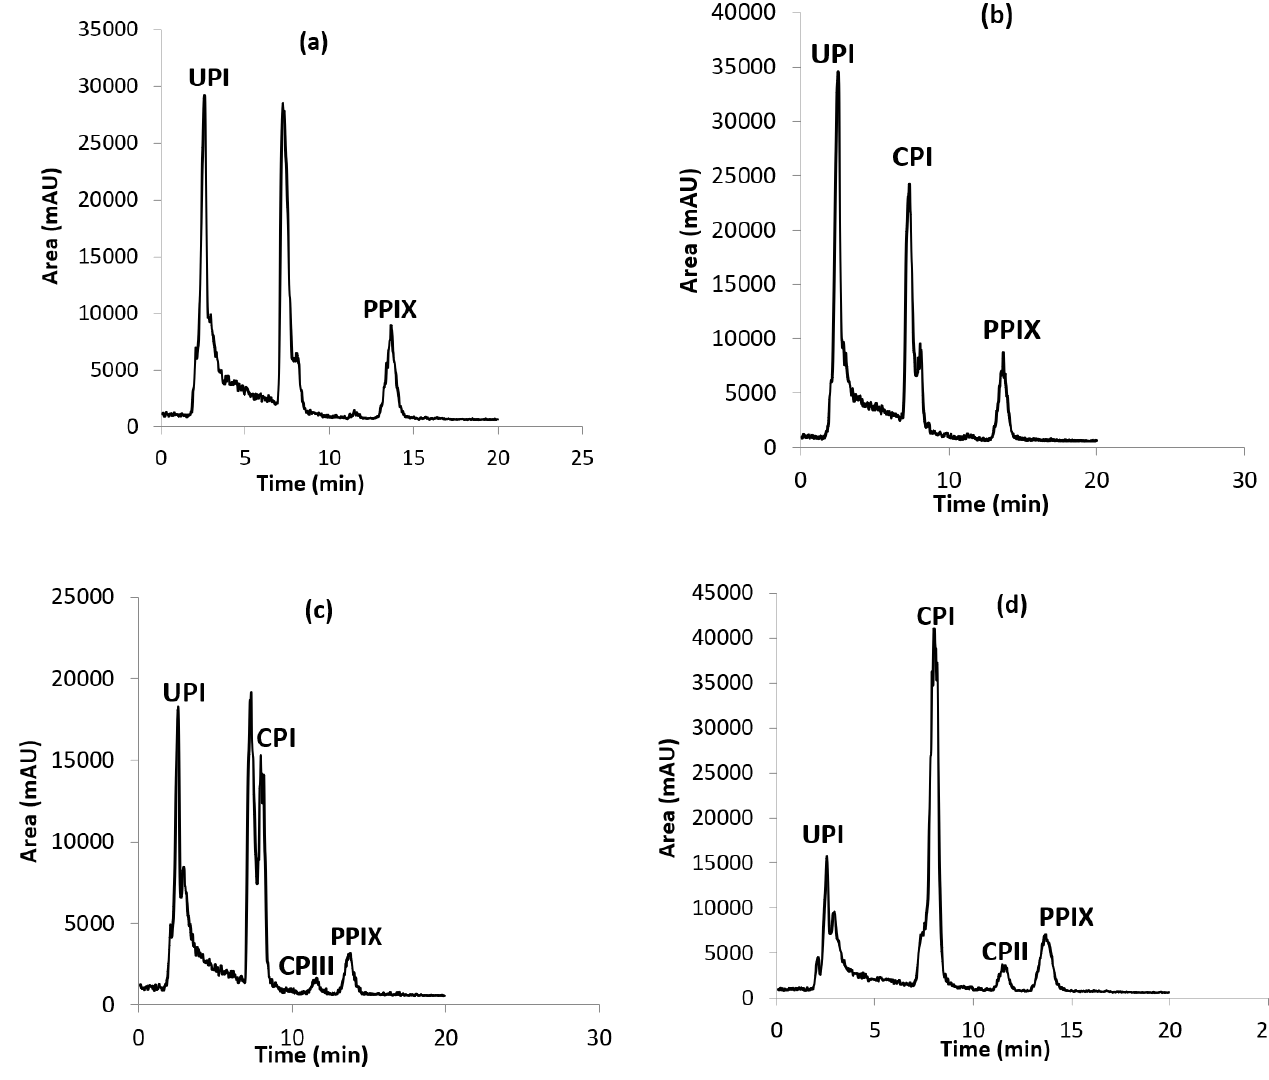
Figure 4. LC-MS chromatograms of four hair samples ( a – d ) from two Southern flying squirrel specimens. Samples ( a , b ) are from back hair and samples c and d are from ventral hair. Conditions: stationary phase Luna C18, 5 µm (size 250 × 0.50 mm 2 ); mobile phase A = 0.2% Formic acid in water/B = 50% ACN + 50% MeOH; flow rate 15 µL min − 1 ; injection volume 5 µL; detection at 402 nm.